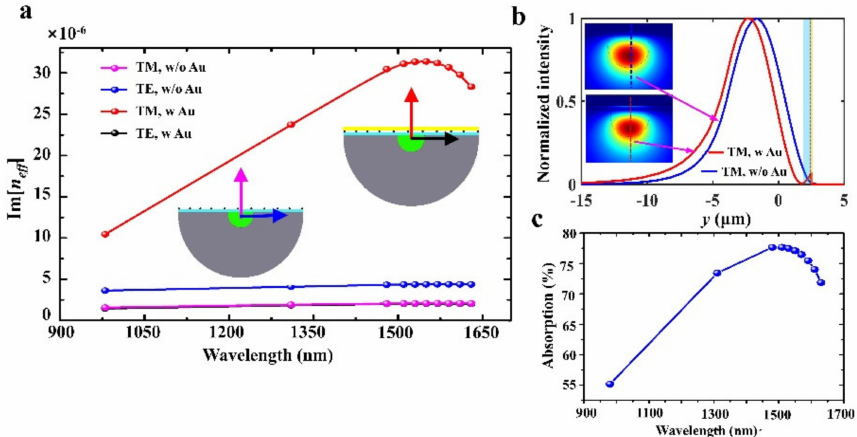
Figure 4. Absorption enhancement by surface plasmon. ( a ) Image parts of the effective refractive indexes of TE and TM guiding modes with and without Au film. ( b ) Normalized intensity of TM mode along the y-axis for the cases with and without Au film. Insets show the mode distributions in the cross plane. ( c ) TM-mode absorption of the AFPD with effective lengths of 5.63 mm region with Au film and 2.37 mm region without Au